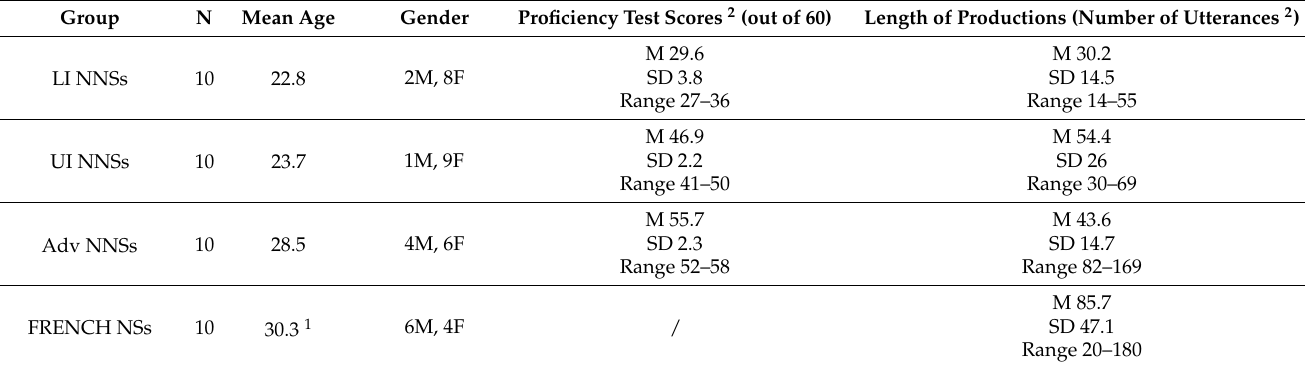
Table 1. Description of participants and characteristics of productions.